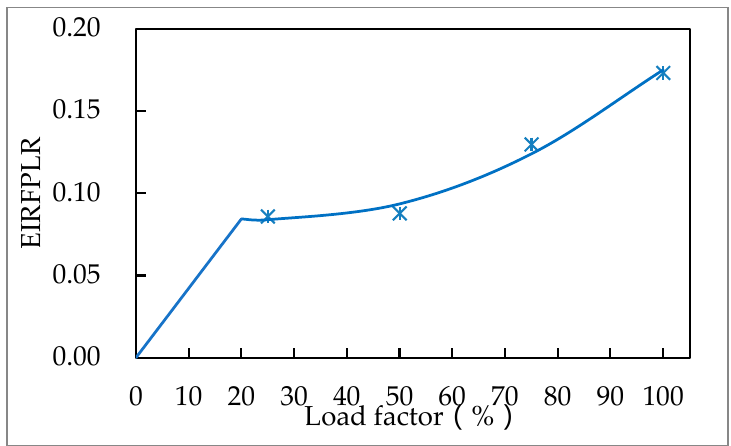
Figure 7. Variation curve of cooling efficiency and part load rate.